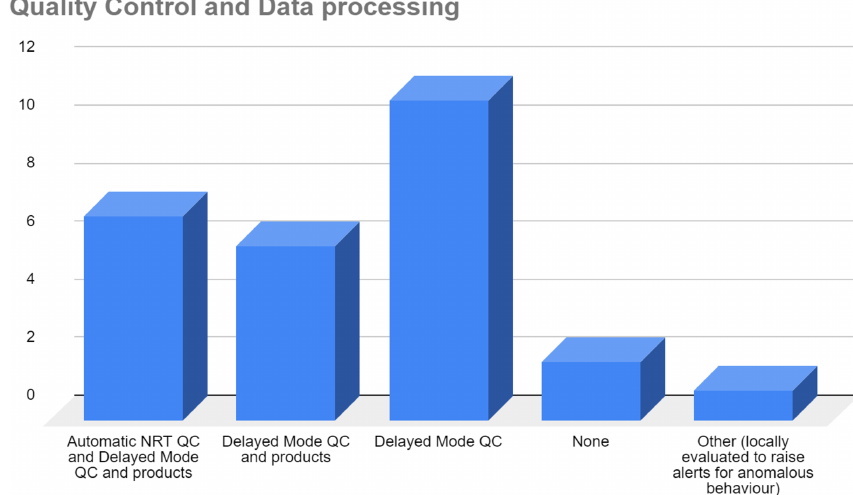
Figure 3. Quality control and data processing strategies followed by M/BS tide gauge network operating